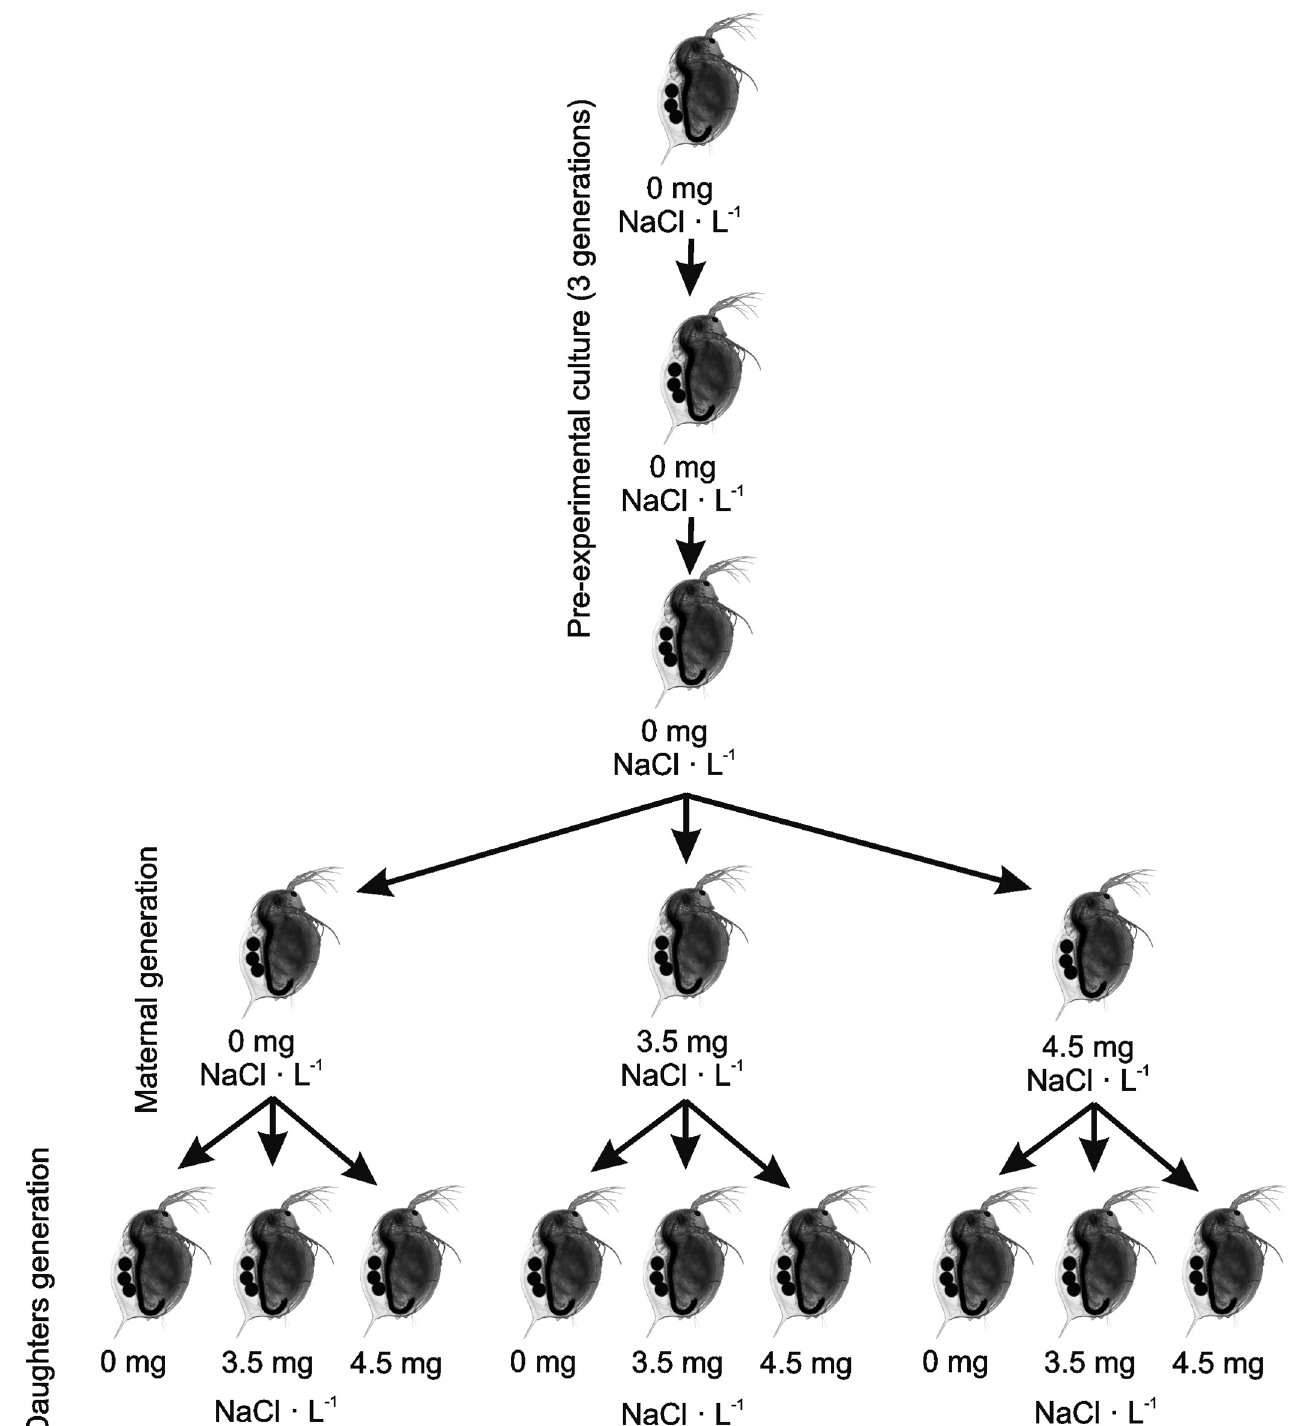
Fig 1. Experimental design.